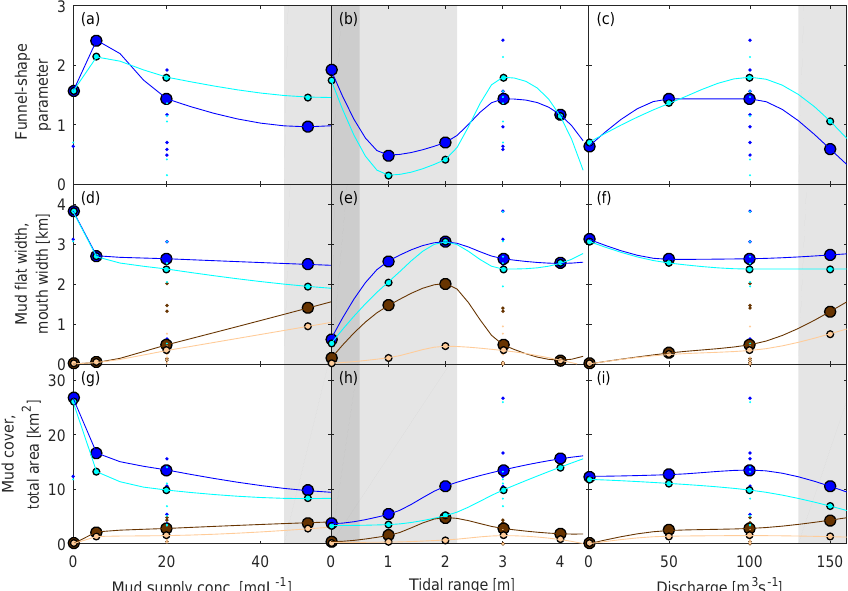
Figure 10. Most important large-scale morphological parameters after 2000 years as a function of the varied boundary conditions: fluvial mud supply concentration, tidal range and fluvial discharge. (a–c) Funnel-shape parameter, (d–f) mouth width (in blue colours) and mudflat width (brown colours) at the mouth and (g–i) total area (blue colours) and mud-covered area (brown colours). The data indicated in light blue and light brown are more conservative estimates as high mudflats (higher than 0 . 5m below the high water level) are masked from the estuary shape from which area, width and funnel shape are calculated. Light grey areas indicate models in the transition from estuary to delta. Dark grey indicates models that evolved into a delta.